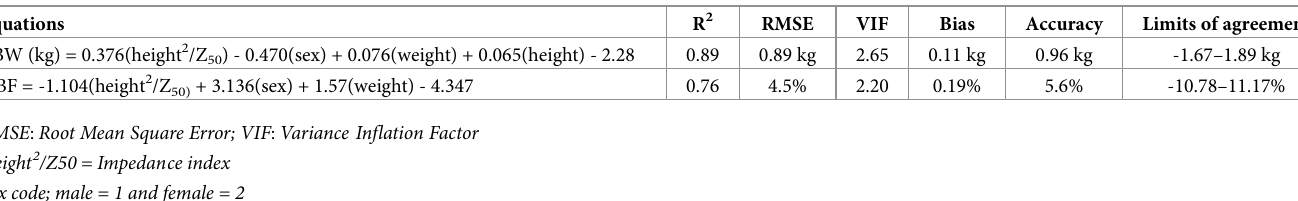
Table 2. BIA prediction equations for TBW and %BF.